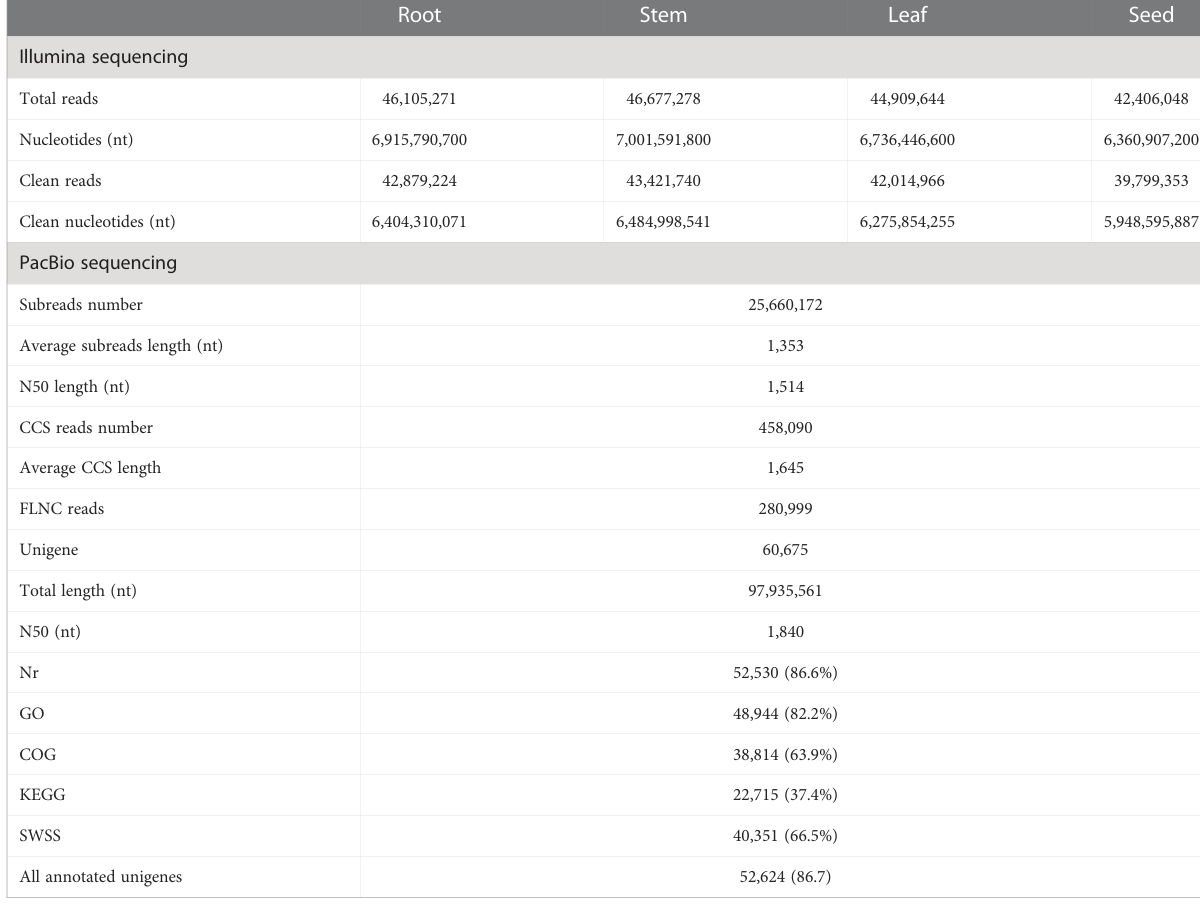
TABLE 2 Summary of the assembly and annotation of S. acutum transcriptome. Root Stem Leaf